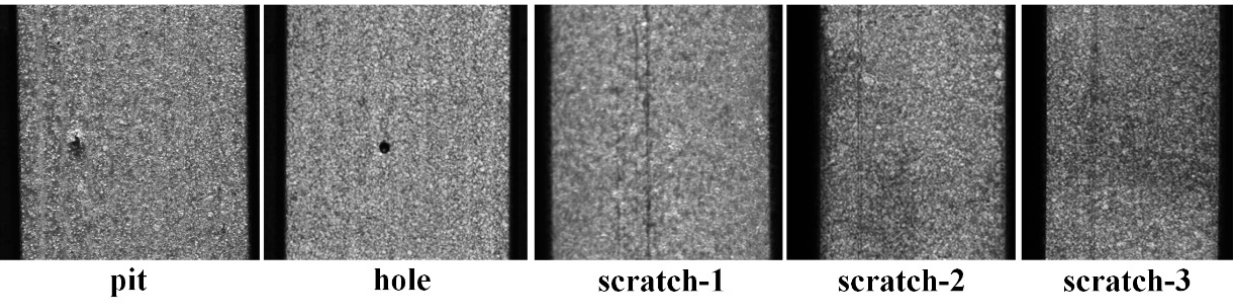
Figure 1. Microchannel Aluminum Flat Tube and Parallel Flow Heat Exchanger.